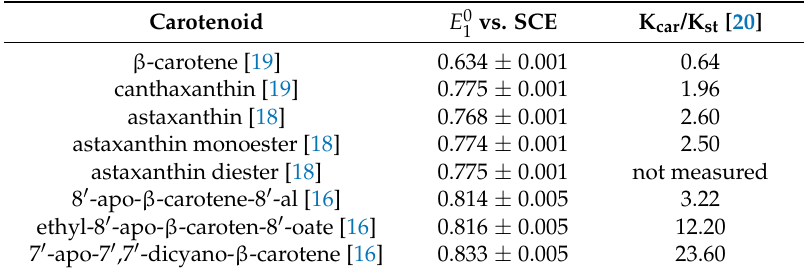
1 ) for selected carotenoids and the relative scavenging ability (cid:2869)